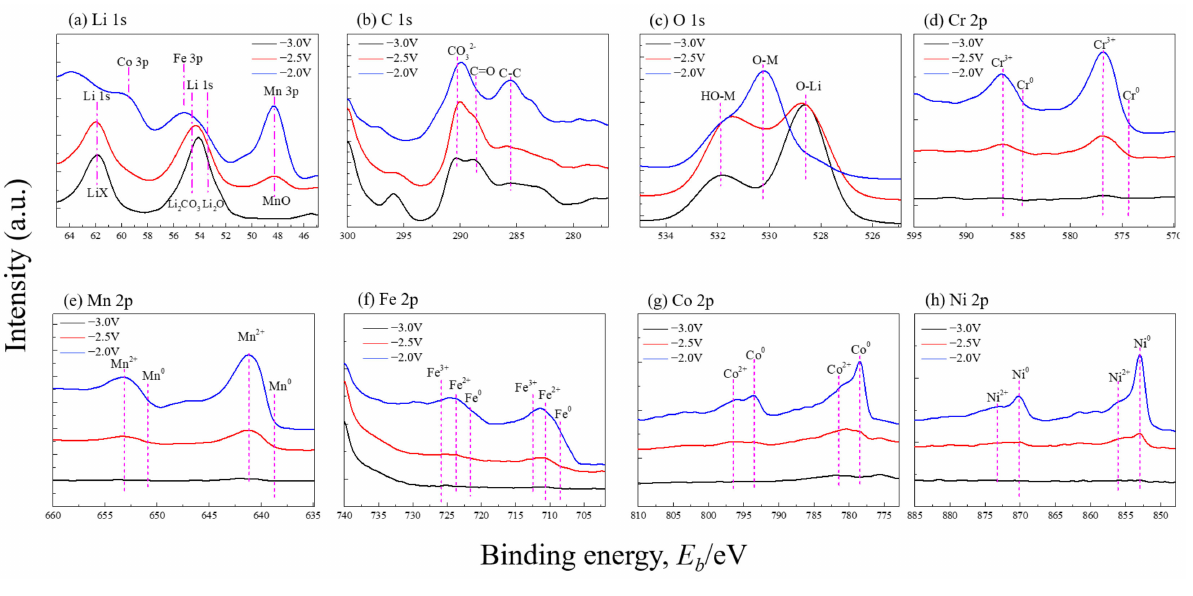
Figure 8. XPS spectra of Li 1s ( a ), C 1s ( b ), O 1s ( c ), Cr 2p ( d ), Mn 2p ( e ), Fe 2p ( f ), Co 2p ( g ), and Ni